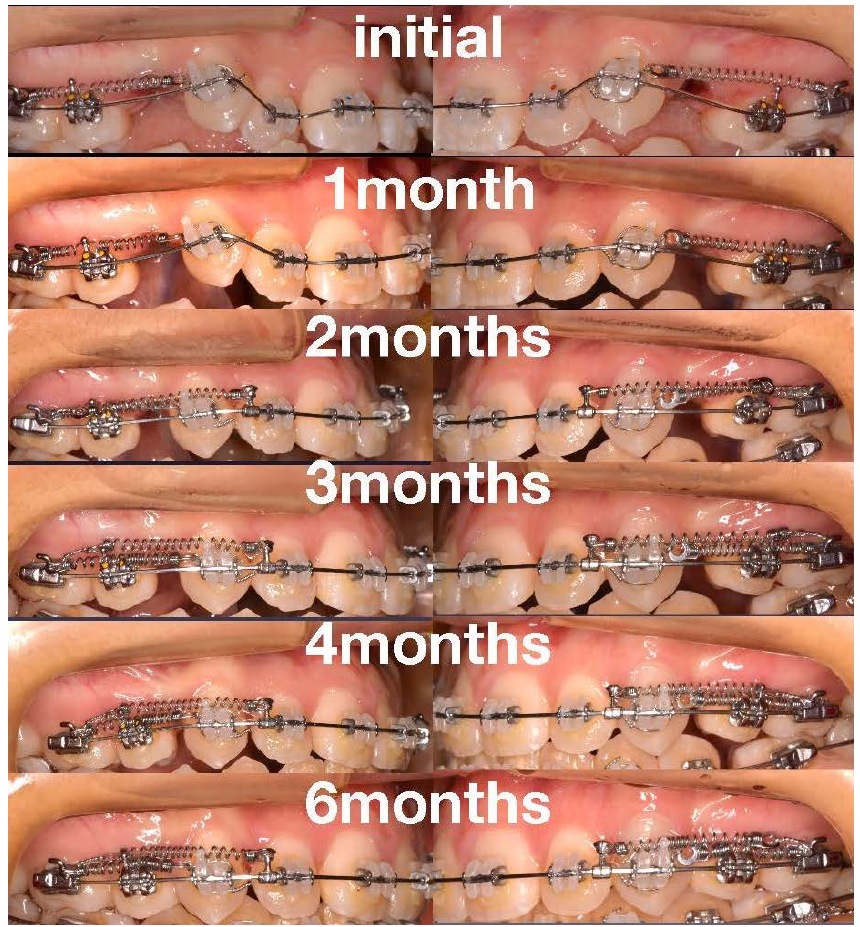
Figure 6. Image of no distal tipping during canine retraction.